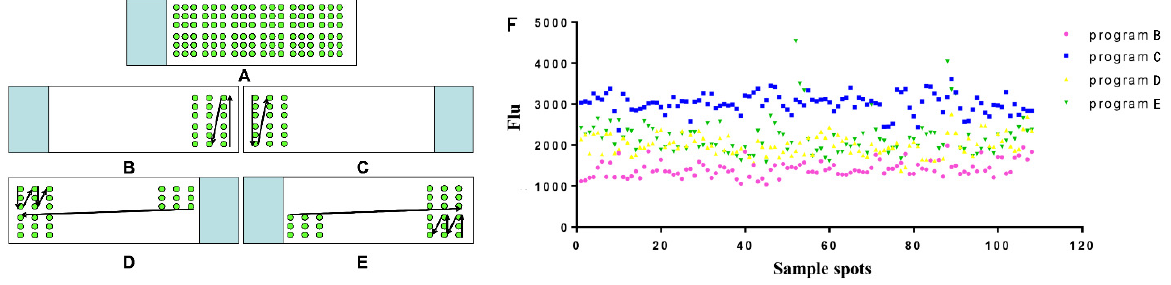
Figure 4. Optimization of biosensor spotting sequence. ( A ) Diagram of the spot sample effect; ( B – E ) Four spotting sequence programs; ( F ) The effect of different spotting sequences on sample spots. sample